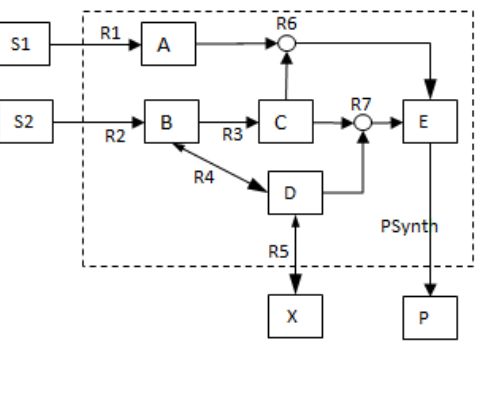
Figure 1. Network layout for an example network ( NetEx ) discussed in